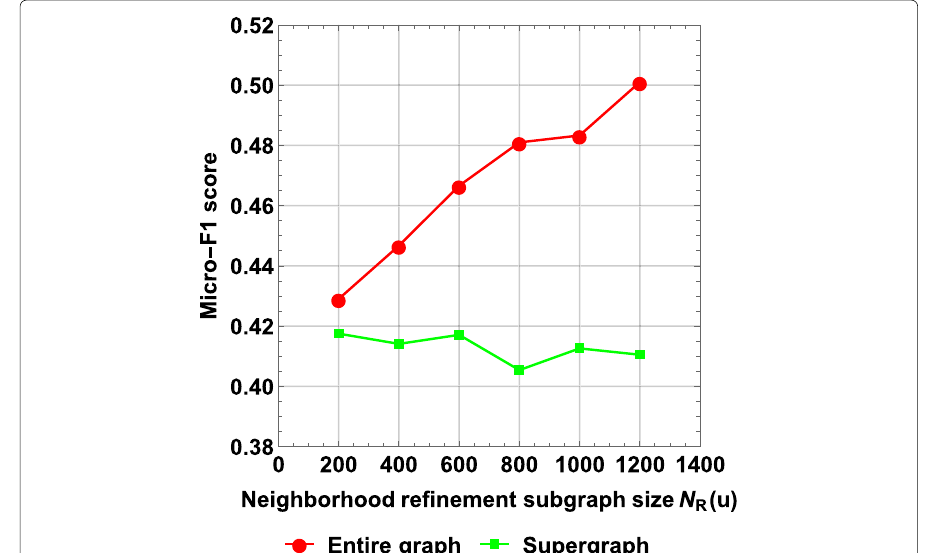
Fig. 8 Performance comparison of SURREAL using two input graphs: entire graph and supergraph. The experiment is conducted using Wikipedia dataset. The | N R ( u ) | is varied from 200 to 1,200, while ( u ) | = 1,200 and d = 128. The performance degrades when using the supergraph instead of entire | N E graph as an input